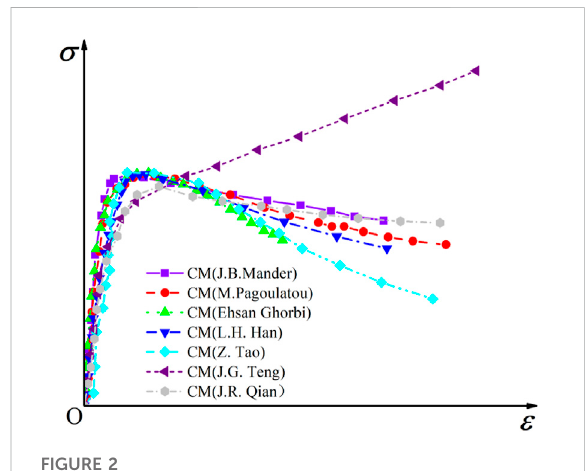
FIGURE 2 Comparison for different constitutive models of concrete.